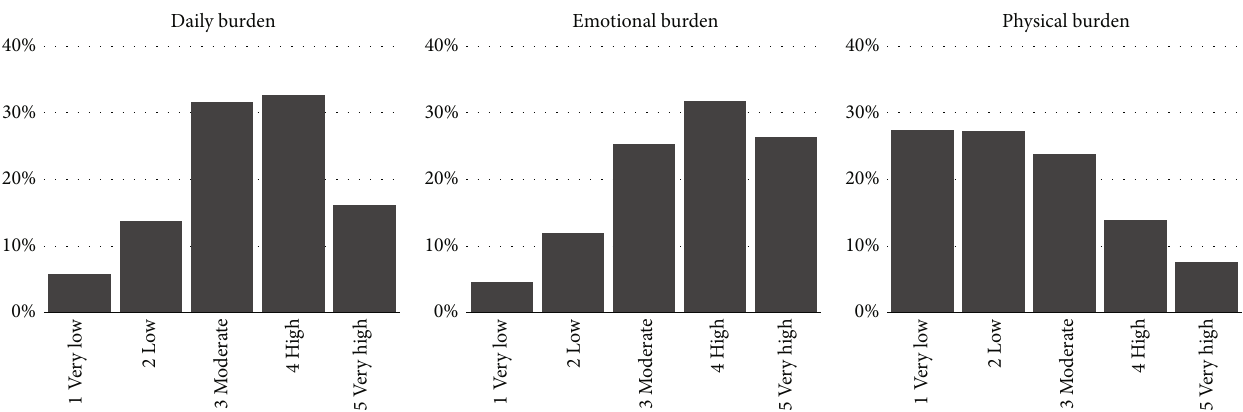
Figure 1: Frequency distribution of daily, emotional, and physical burdens reported by German parents living with a child with type 1 diabetes. Note: daily burden ( n = 1,093 ): Mdn = 3 (moderate) and M ð SD Þ = 3 : 40 ð 1 : 09 Þ ; emotional burden ( n = 1,096 ): Mdn = 4 (high) and M ð SD Þ = 3 : 63 ð 1 : 13 Þ ; physical burden ( n = 1,086 ): Mdn = 2 (low) and M ð SD Þ = 2 : 47 ð 1 : 24 Þ . Table 2: Median and mean (SD) of daily, emotional, and physical parental burdens by parent ’ s gender, living arrangement, child ’ s age, and technology use. Daily burden Emotional